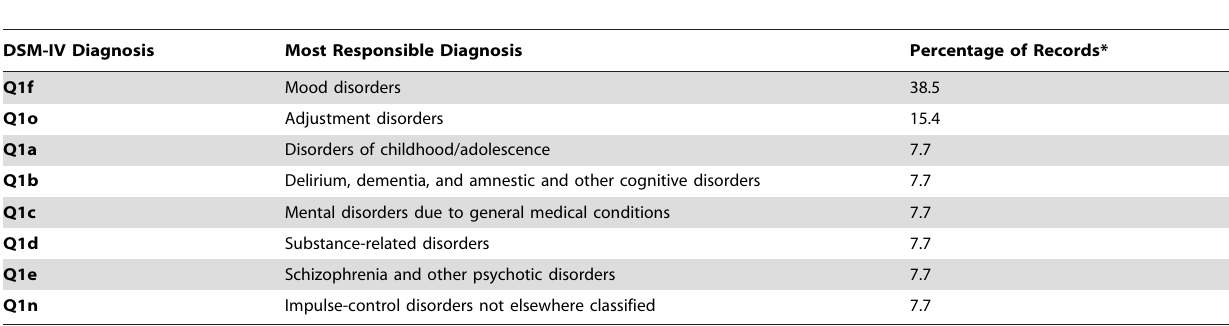
Table 4. Percentage of records of the top most responsible DSM-IV diagnoses among individuals diagnosed with FAS who used adult inpatient mental health services (acute and psychiatric care) in Ontario in